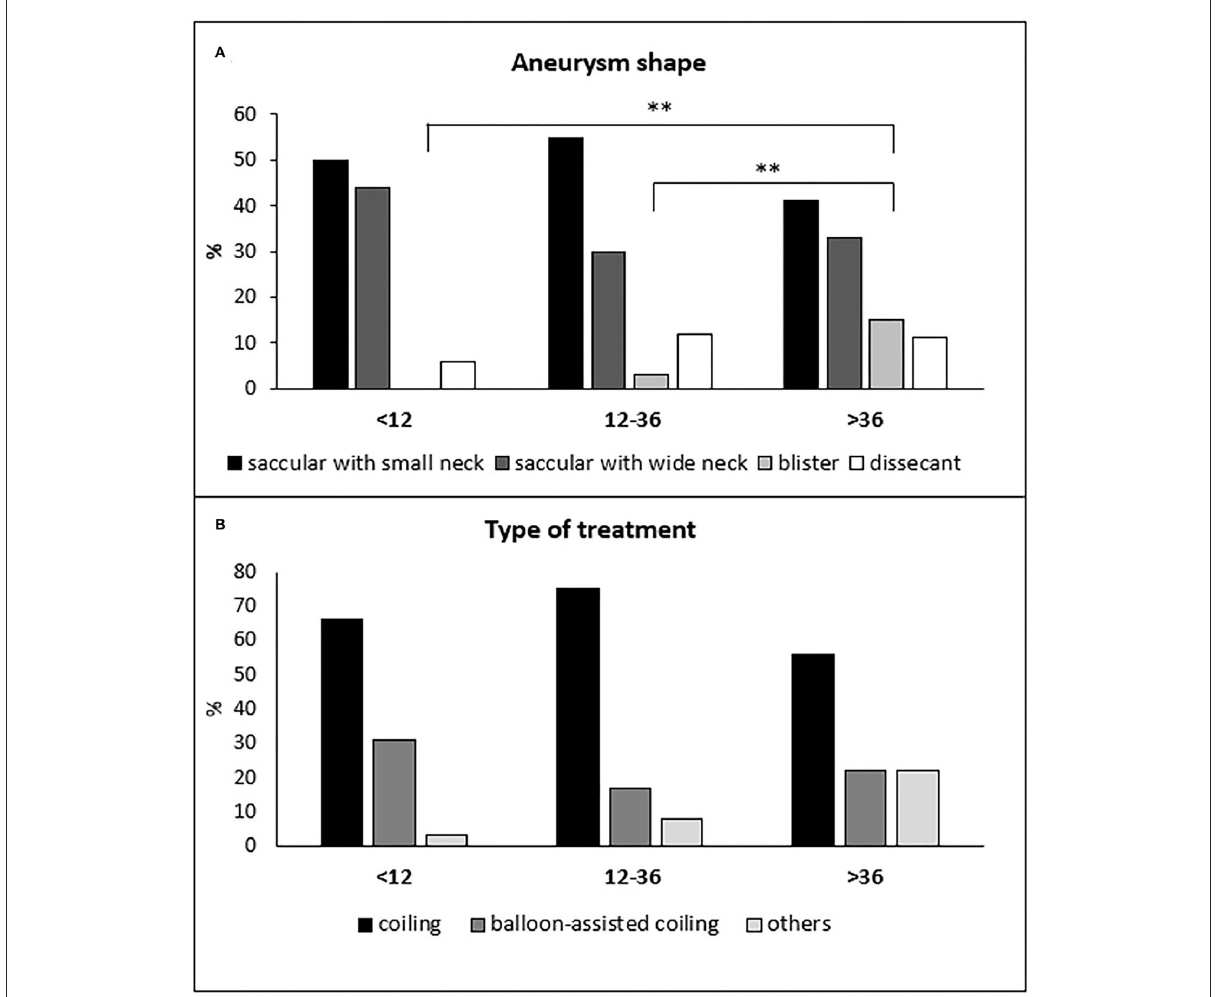
FIGURE1 Distribution of the different aneurysm shapes (A) and types of treatments (B) in the hyper-early, early, and delayed treatment groups of patients. (A) ** p ≤